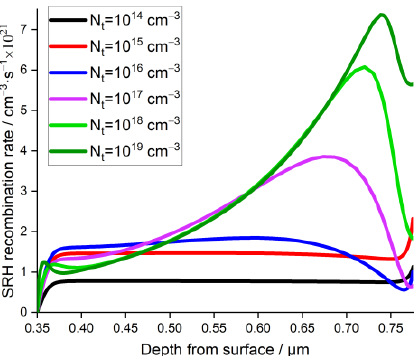
Figure 6. Variation in ( a ) PCE, ( b ) V oc , ( c ) FF, and ( d ) J sc for absorber with different defect density and acceptor doping concentration.